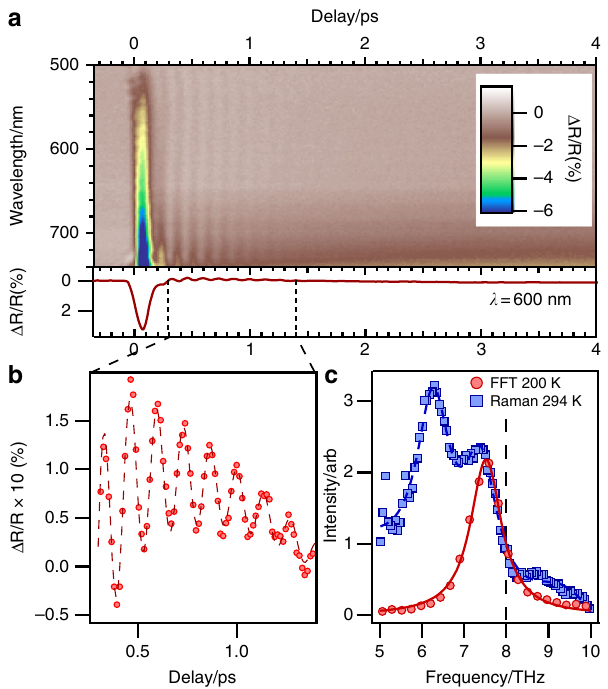
Fig. 1 Transient response of V 2 O 3 to photoexcitation. a Time- and wavelength-resolved response of V 2 O 3 after excitation with a 40 fs 1.5 eV pump pulse at 1 kHz repetition rate, a pump fl uence of 8 mJ cm − 2 and a base temperature of 200 K. The 2D data are averaged over a 100-nm-wide region, centred at 600 nm to extract a 1D time trace. b Zoom of the data to show the measured coherent phonon oscillations (circles) together with the fi t (dashed line) with a 7.4 THz mode. c Fourier transform of the same data (blue circles) after differentiation, in order to remove the slow dynamics. A Lorentzian fi t (blue line) gives a central frequency of 7.5 THz. The extracted frequency is in good agreement with the Raman data, taken at room temperature (blue line). The fi rst peak (~6 THz) corresponds to the E g mode, which is not measured in our time-resolved measurement, and the second corresponds to the observed A 1g mode. The mode frequencies are in good agreement with Ref. 3 . The black dashed line is the blue-shifted frequency reported in Ref. 1